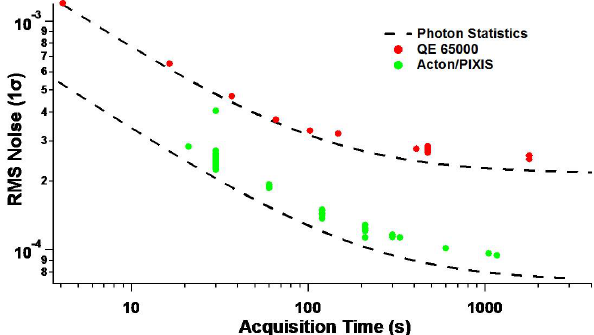
Fig. 4. RMS Photon noise as a function of acquisition time as mea- sured by the two spectrometer/detector systems used in this study. The theoretical limit of the noise reduction is shown by the dashed